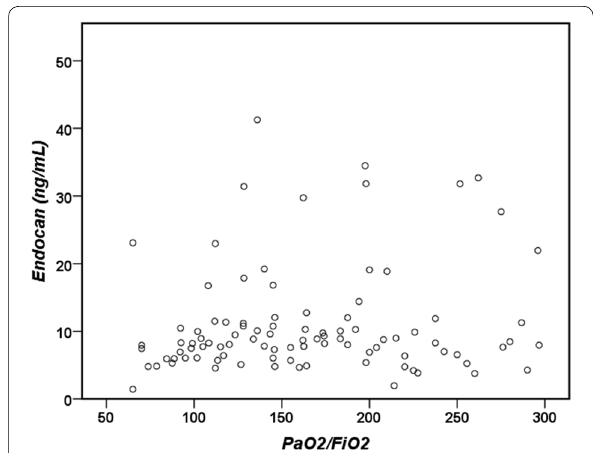
Fig. 5 Correlation of endocan concentrations with PaO 2 /FiO 2 ratio at T0 ( r 0.137, p = =